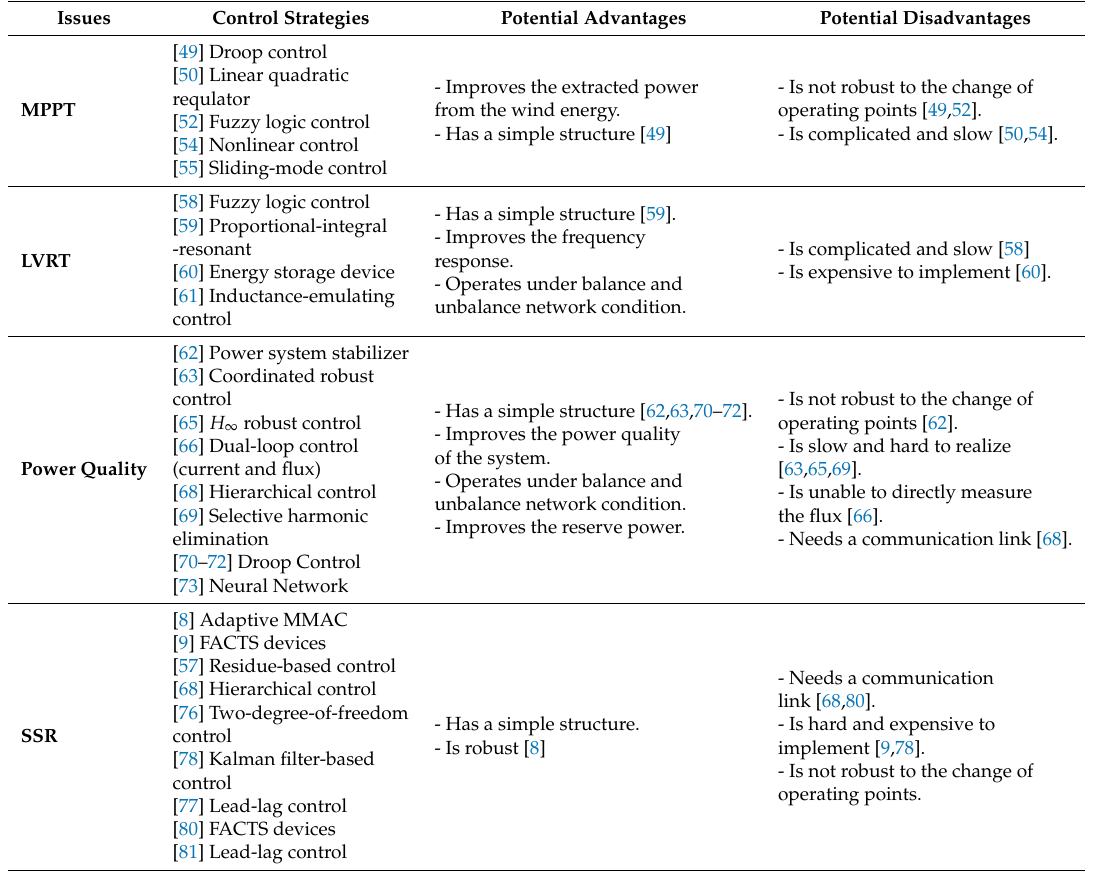
Table 3. Supplementary controllers for Type III wind turbines.